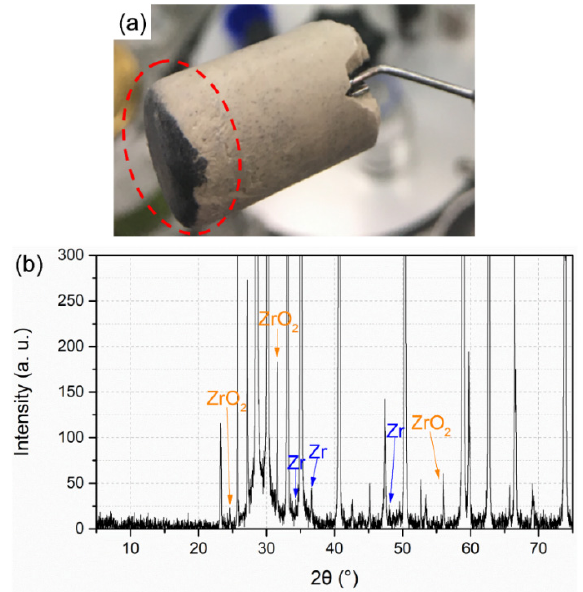
Figure 4. ( a ) Salt ingot obtained from the cathode basket in test 2; ( b ) XRD pattern of the black precipitate at the bottom of the salt ingot, represented as a red circle in Figure 4a